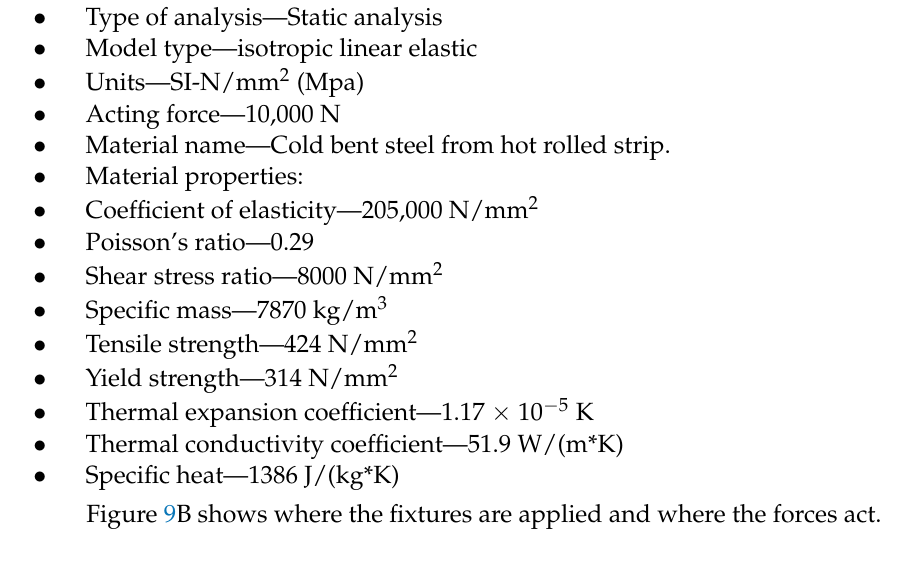
Figure 8. ( A ) – Anti-slip pad installed on the fork of a forklift with an europallet; ( B ) – Anti-slip pad with lock and composite Figure 8. ( A )–Anti-slip pad installed on the fork of a forklift with an europallet; ( B )–Anti-slip pad with lock and composite friction material; ( C ) – Anti-slip pad installed on the fork of a forklift with an europallet; ( D ) — Anti-slip pad with lock; ( E ) — friction material; ( C )–Anti-slip pad installed on the fork of a forklift with an europallet; ( D )—Anti-slip pad with lock; Anti-slip pad with lock; ( F ) — Anti-slip pad with lock and composite friction material. ( E )—Anti-slip pad with lock; ( F )—Anti-slip pad with lock and composite friction